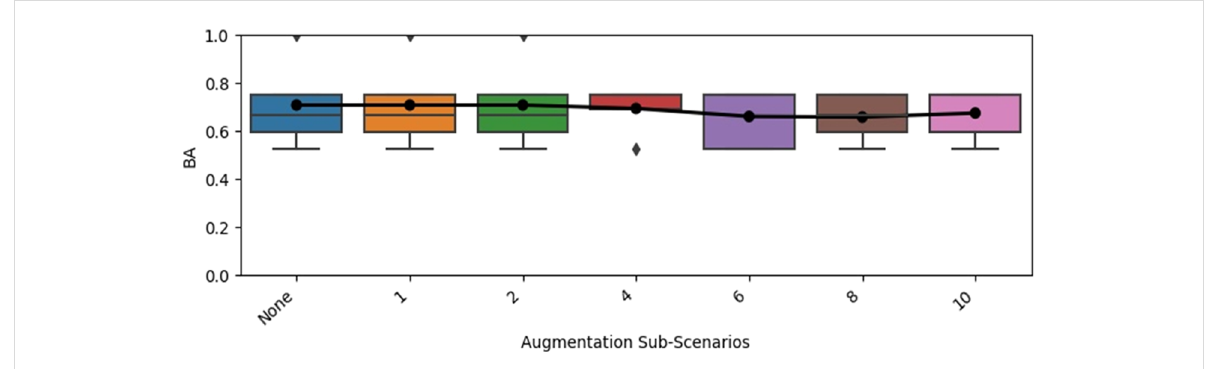
Figure 7: Nested cross-validated balanced accuracy (BA) obtained with multiple descriptor Random Forest models for the 120 hpf excess lethality endpoint when the cross-validation training sets were supplemented with multiple noised replications (1–10 replications, with certain numbers skipped in keeping with literature precedence [36]) of themselves, compared to the results obtained with no data augmentation (“None”). (The results with no data augmentation were reported in Table 1). The results across all test folds are summarized in terms of a boxplot, with the arithmetic mean result superimposed. The whiskers extend to data points lying up to 1.5 times the interquartile range above and below the upper and lower quartiles, respec- tively. The triangles/diamonds represent outlier results, which are higher and lower than the upper and lower whiskers,